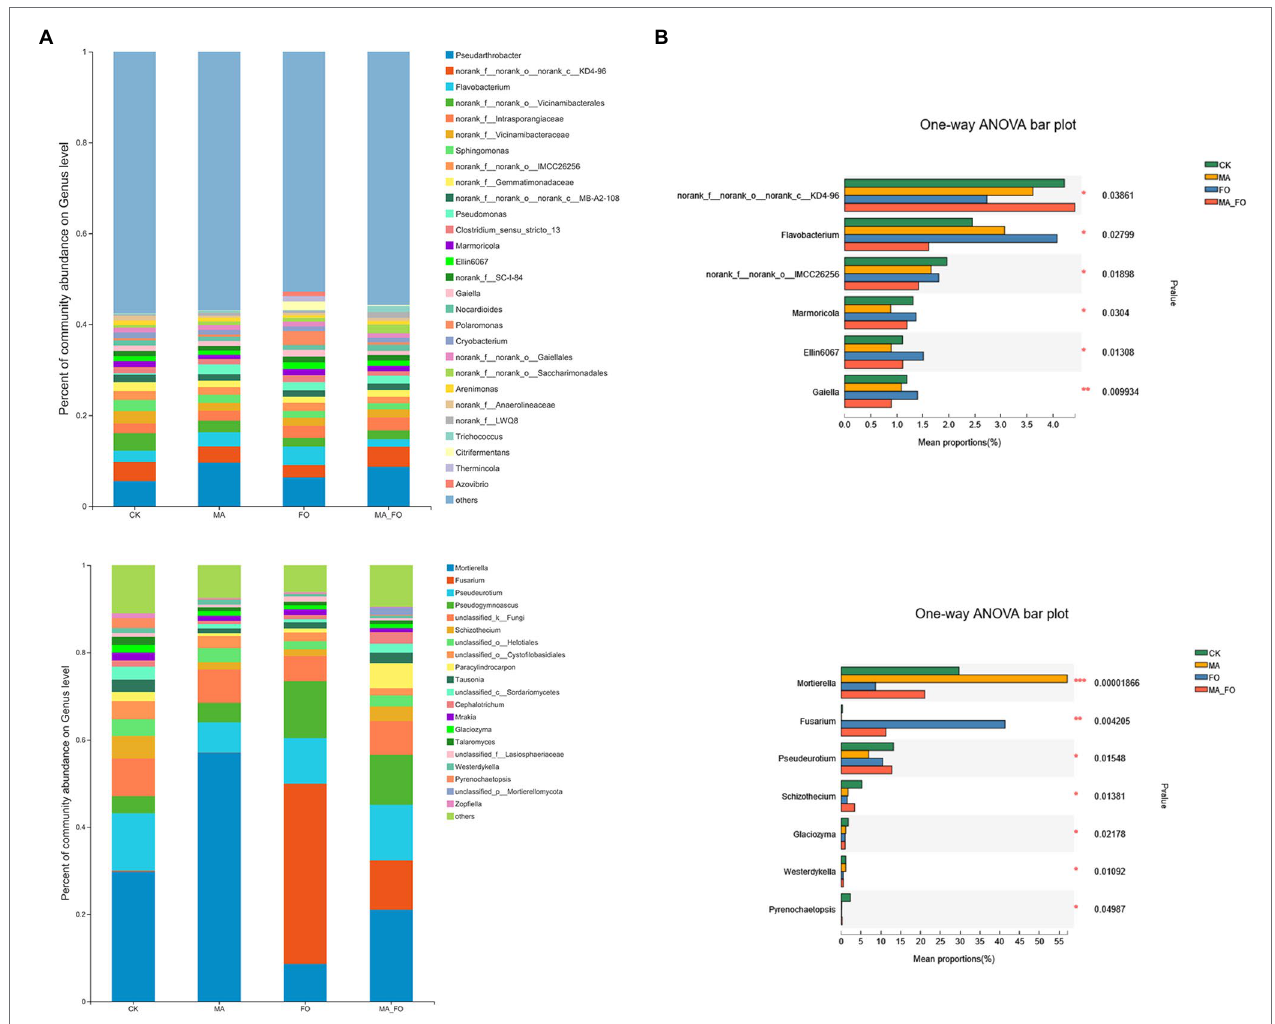
FIGURE 8 | Analysis of microbial composition and differences in ginseng rhizosphere soil. (A) Relative abundance at the genus level of bacteria and fungi, where “others” represents species with relative abundance less than 1% in all samples; (B) One-way univariate analysis of variance (ANOVA) was used to test the significance of differences between groups at the genus level of bacteria and fungi. The y-axis represents the species names at the genus level, the x -axis represents the average relative abundance in different groups of species, and the columns with different colors represents different groups. Far right is the value of p , * p < 0.05; ** p < 0.01; *** p <